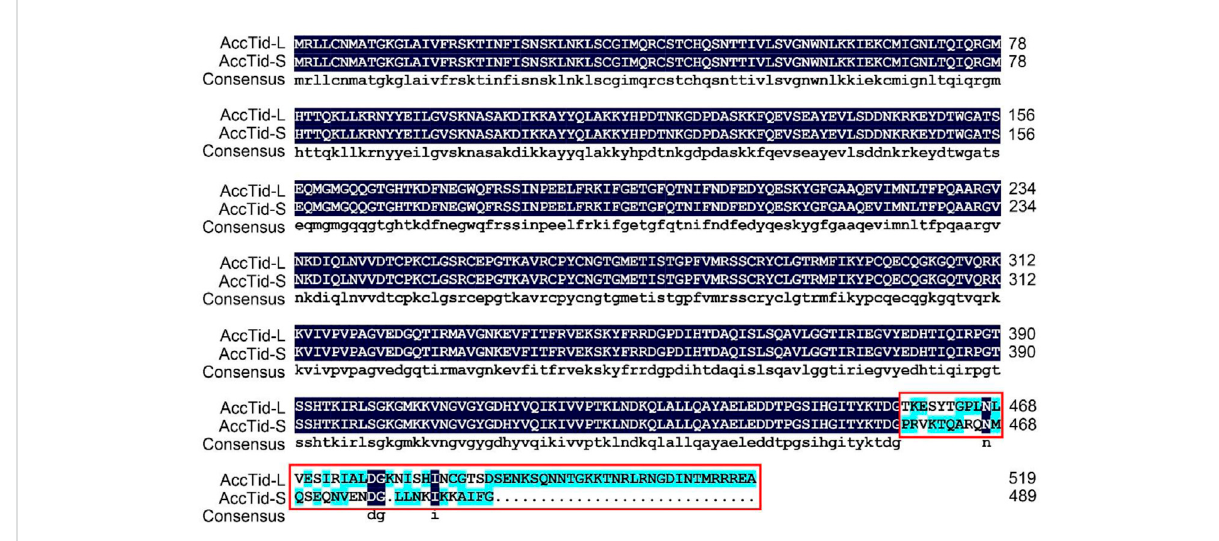
FIGURE 1 Multiple aminoacid alignmentofAccTid-Land AccTid-S.Thedifference between AccTid-LandAccTid-Sisindicatedwith aredbox. AccTid-L: long isoform of AccTid. AccTid-S: short isoform of AccTid.